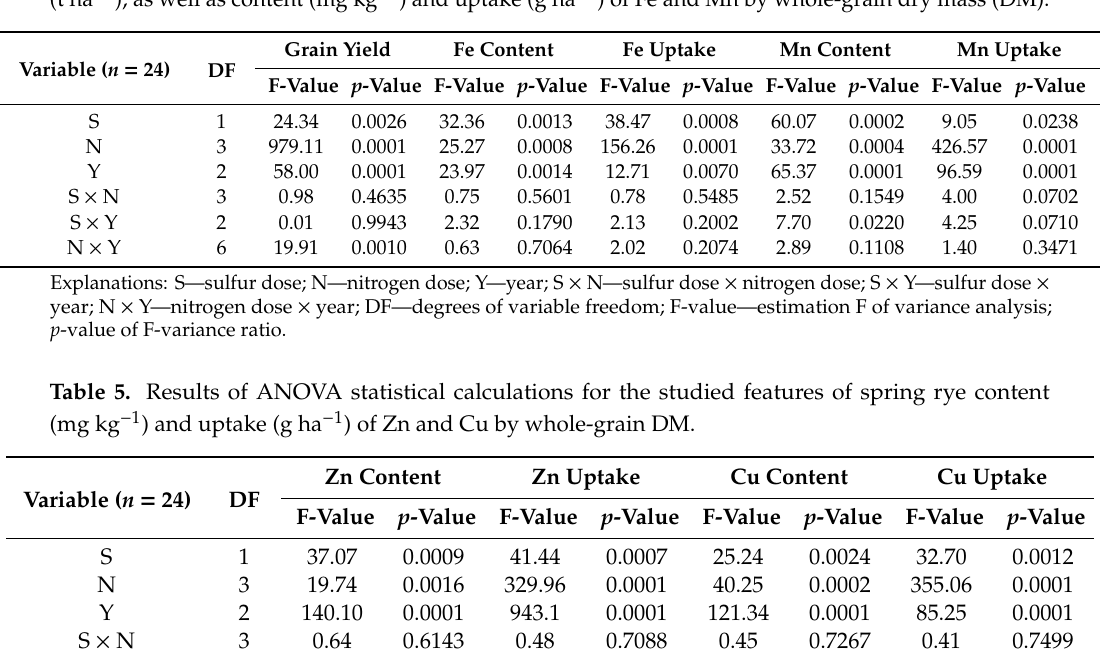
Table 4. Results of ANOVA statistical calculations for the studied features of spring rye grain yield (t ha − 1 ), as well as content (mg kg − 1 ) and uptake (g ha − 1 ) of Fe and Mn by whole-grain dry mass (DM).